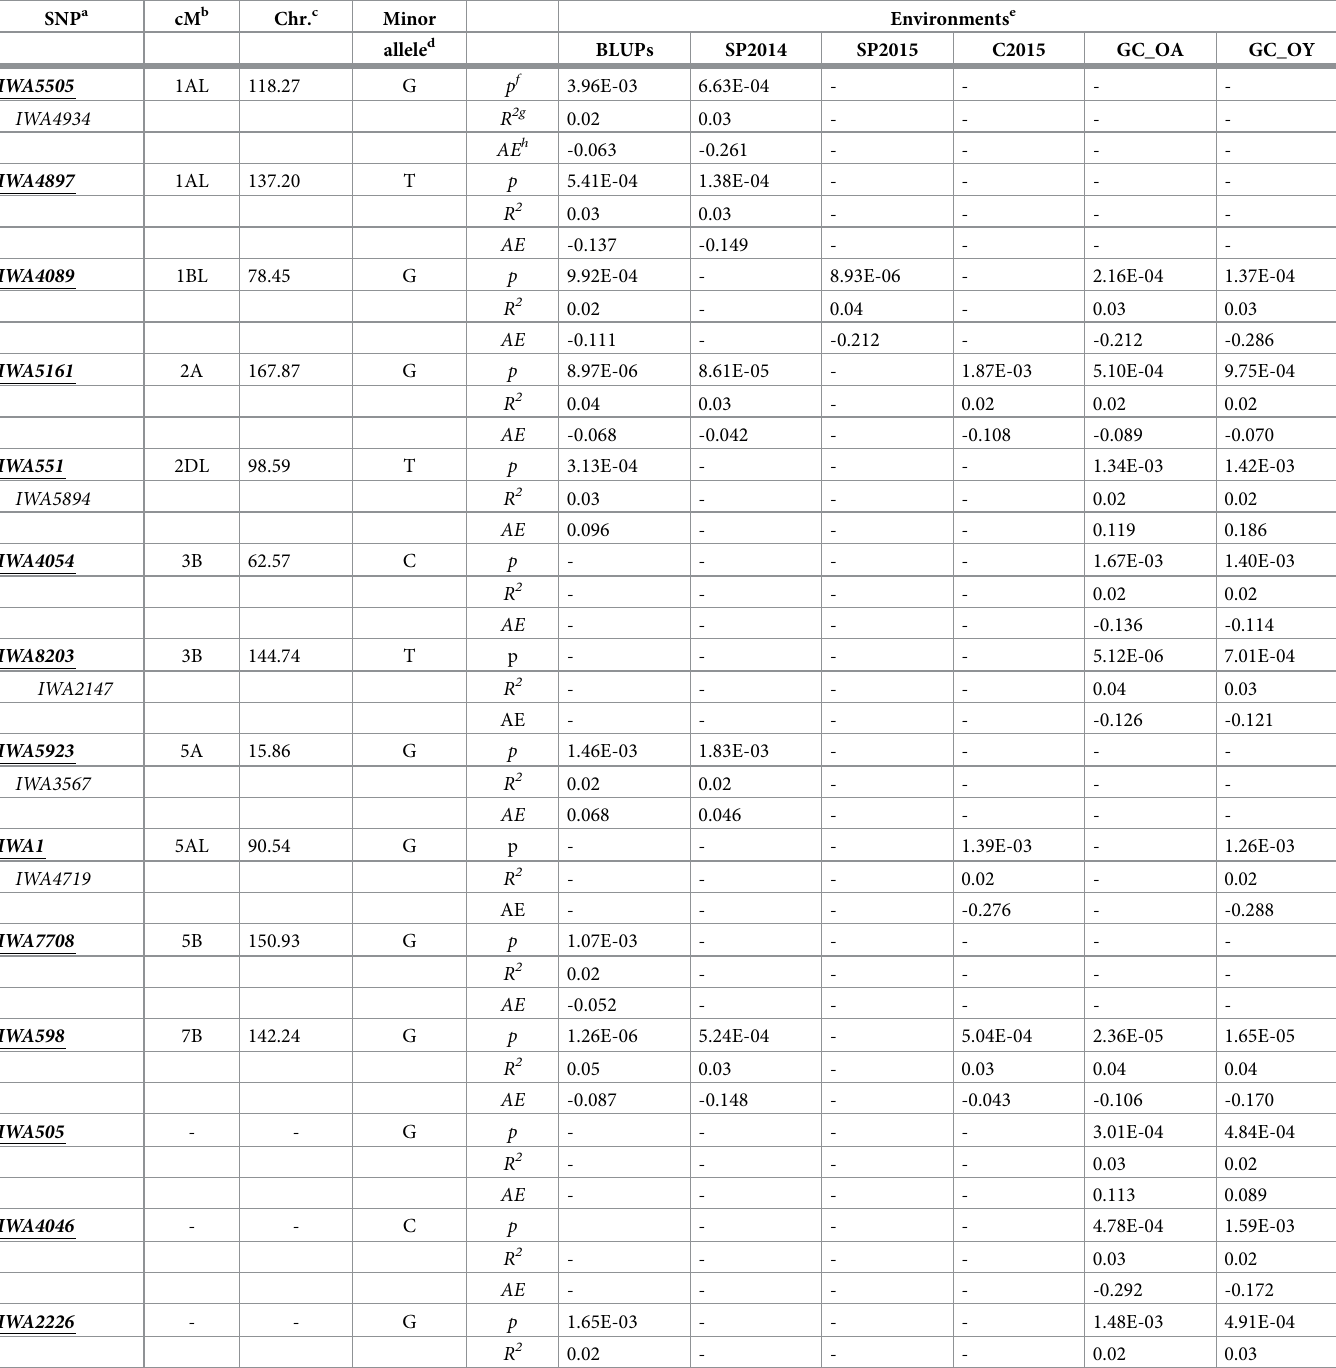
Table 2. Genome-wide association mapping analysis (GWAS) results for eyespot disease resistance in winter wheat Panel B. Markers associated with eyespot disease resistance with a p -value (cid:20) 0.005 and identified in two or more environments including BLUPS, are reported. SNP a cM